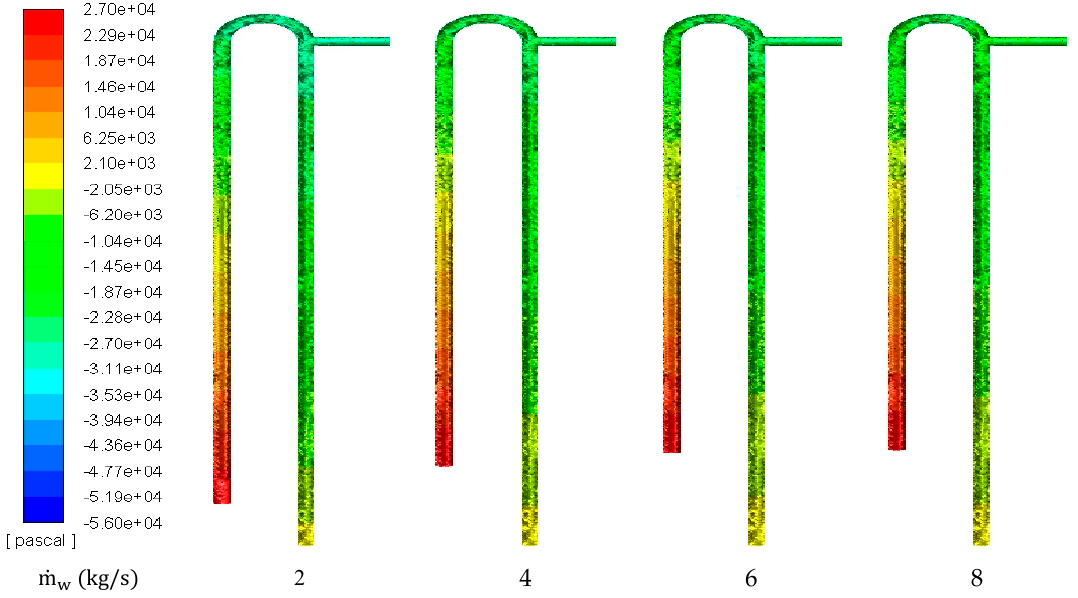
Figure 12. Pressure contours at different flow ratios and X (cid:2933) = 461.42, α (cid:2923) = 0.7 and X (cid:2932) = 0.1.